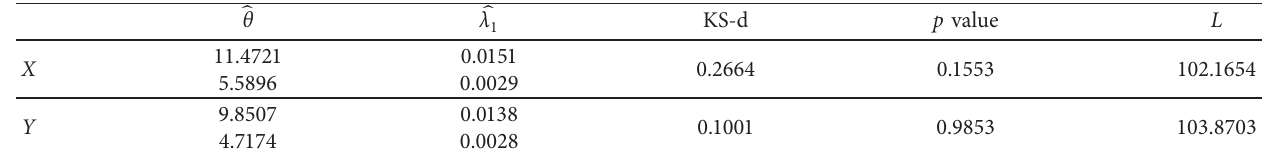
Table 8: KS distance and its p value and MLE.